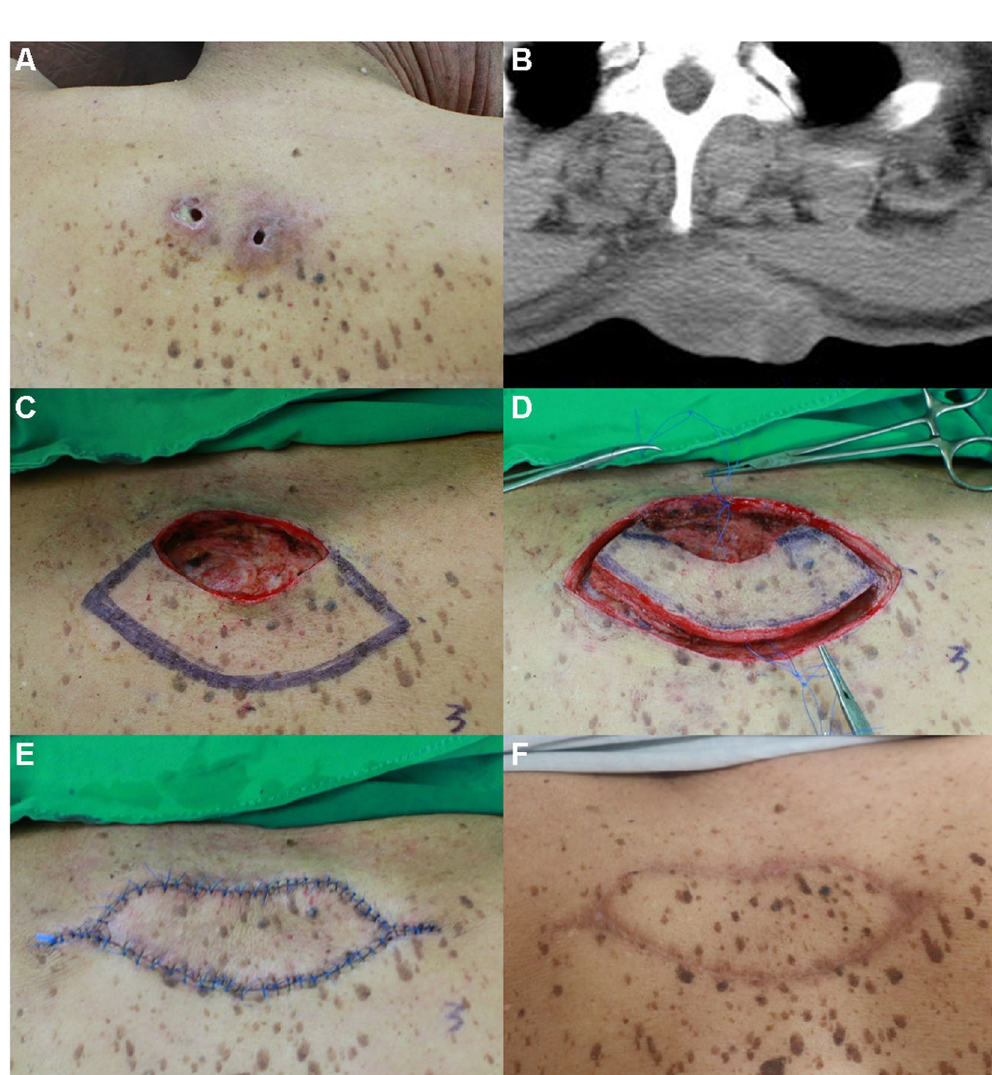
Figure 2. Keystone-design perforator island flap (KDPIF) reconstruction after complete excision of the ruptured epidermoid cyst (EC) with cellulitis in a 60-year-old man. ( A ) A 5-cm solid lesion having an indefinite border was palpated with two skin openings observed on the upper midline of the back. ( B ) Computed tomography scan revealed a ~7.1 × 3.4 × 3.3 cm multi-loculated cystic mass with wall enhancement, involving the skin and whole subcutaneous layer of the upper back. ( C ) The design of the flap. The final defect size was 3 × 6 cm and a 3.5 × 10 cm-sized KDPIF was designed in the lower side of the defect. ( D ) The island-form of the flap was made. ( E ) Postoperative clinical photograph immediately after the flap inset. ( F ) Postoperative clinical photograph of the flap after 12 months of